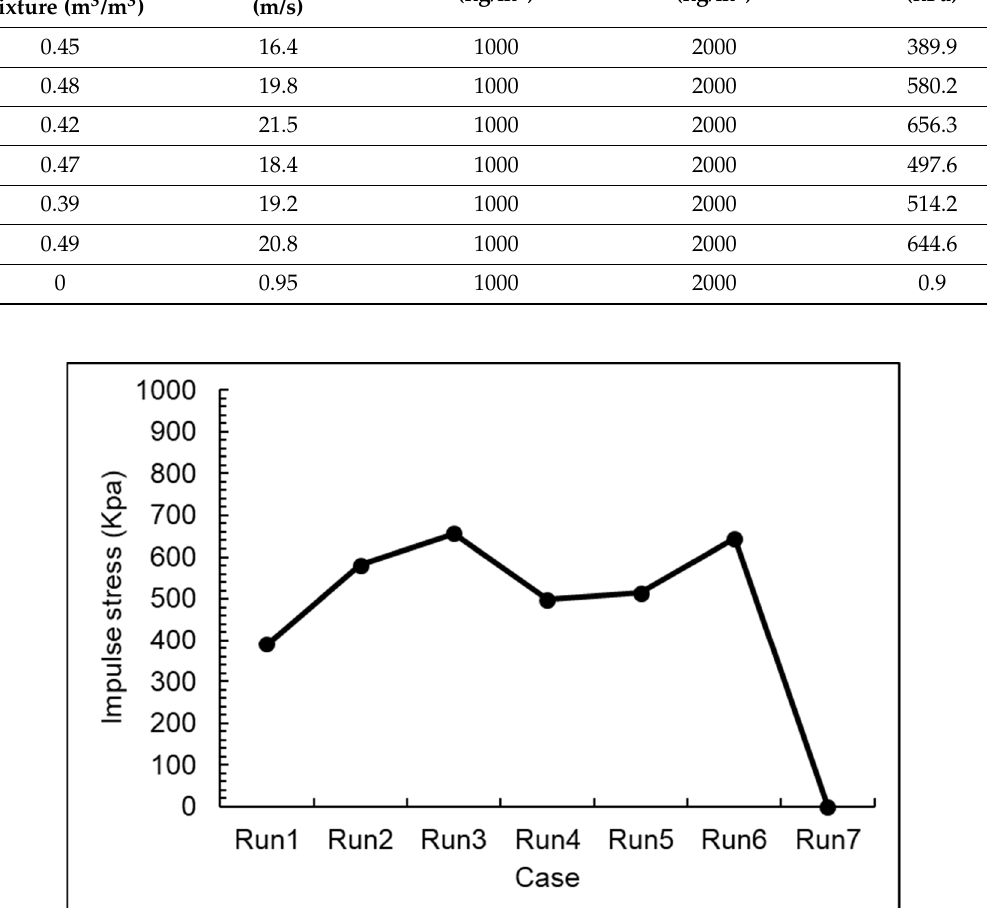
Figure 12. Impulse stress at the target area 1 (see Figure